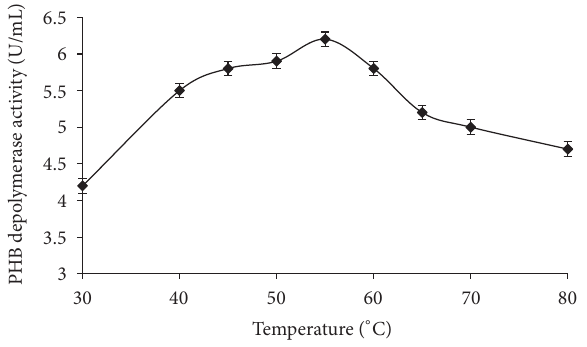
F 8: Temperature optima of F. solani PHB depolymerase.